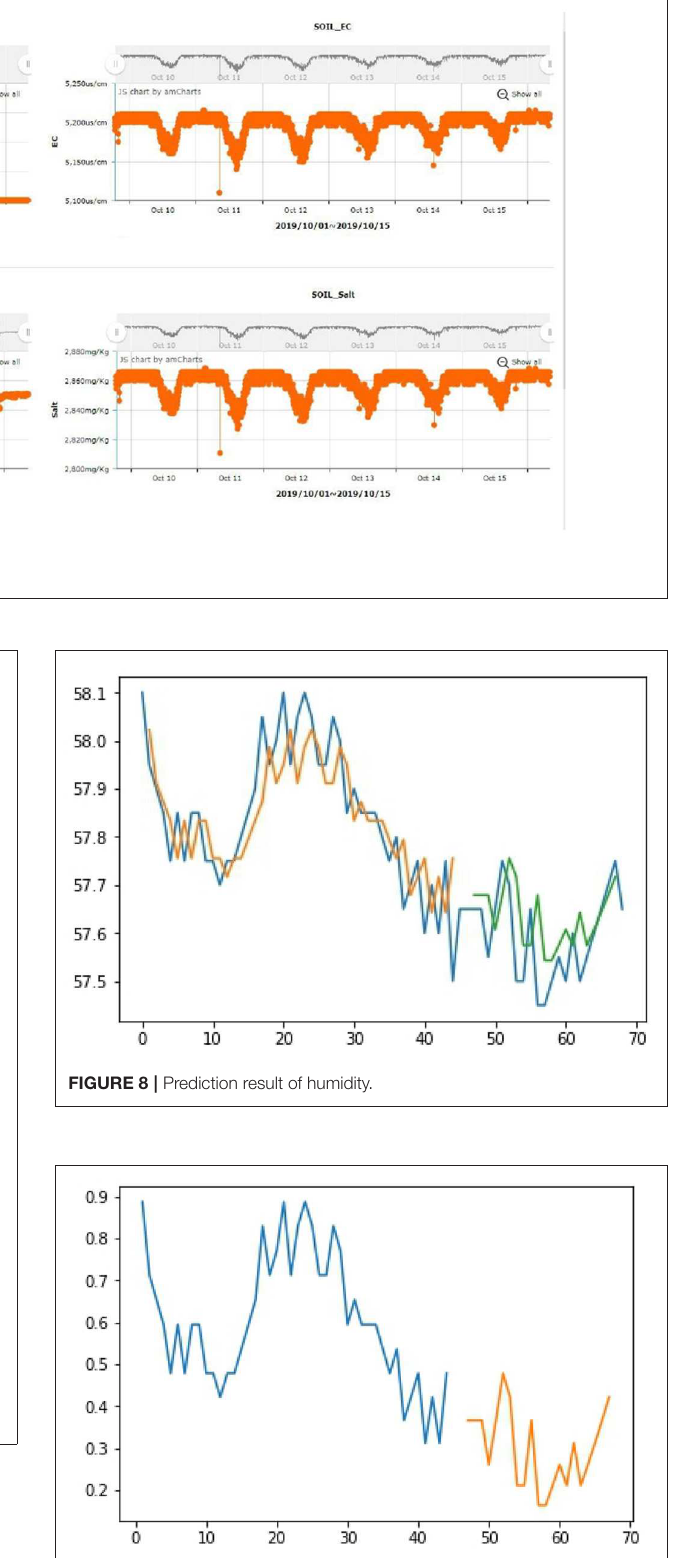
FIGURE 9 | Prediction result of